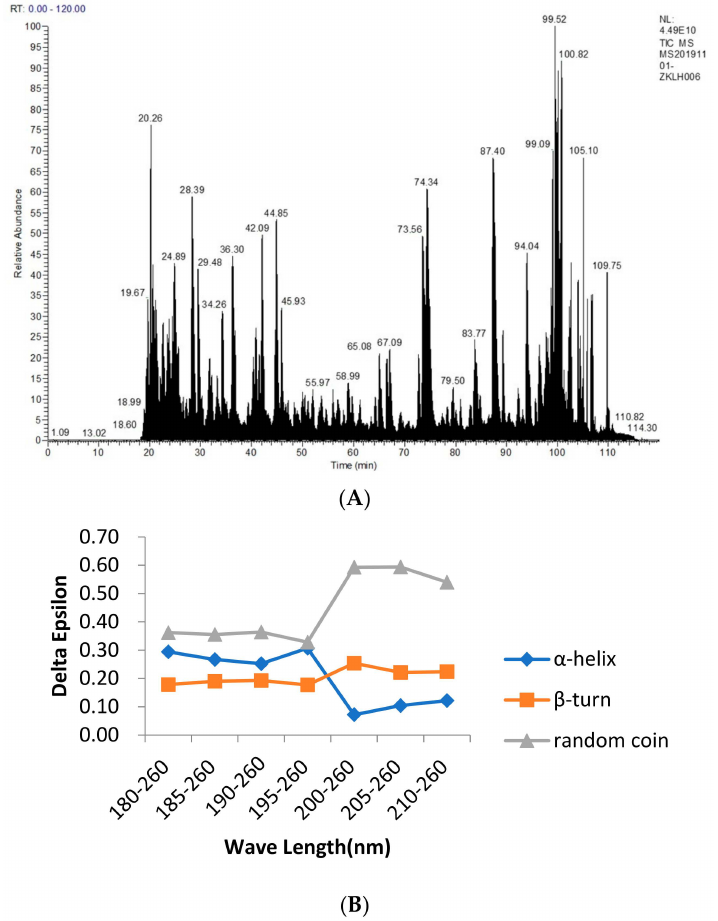
Figure 1. Mass spectrometry analysis of the cashew allergenic proteins ( A ) and the circular dichro- gram ( B ) to identify cashew allergenic proteins. Figure ( A ) is from the results of the protein sequencing analysis of cashew allergens. The main purpose of this experiment is to identify two major allergens by Western blotting and obtain the sequences of the two allergens by mass spectrometry sequencing, as it is measured by liquid mass spectrometry. ESI mass spectrometry provides the total ion map. After the NCBI database query, the allergen sequence and the results obtained by mass spectrometry are compared. The secondary structure predicted by the Protein program in DNAstar is compared with the protein structure determined by circular